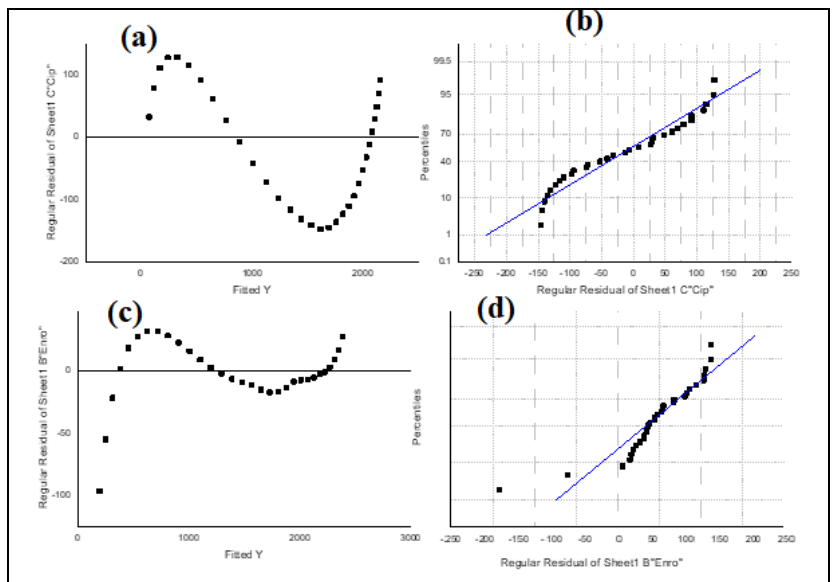
Figure 4. Data fitting of ENRO and CIP biodegradation to Gompertz model.